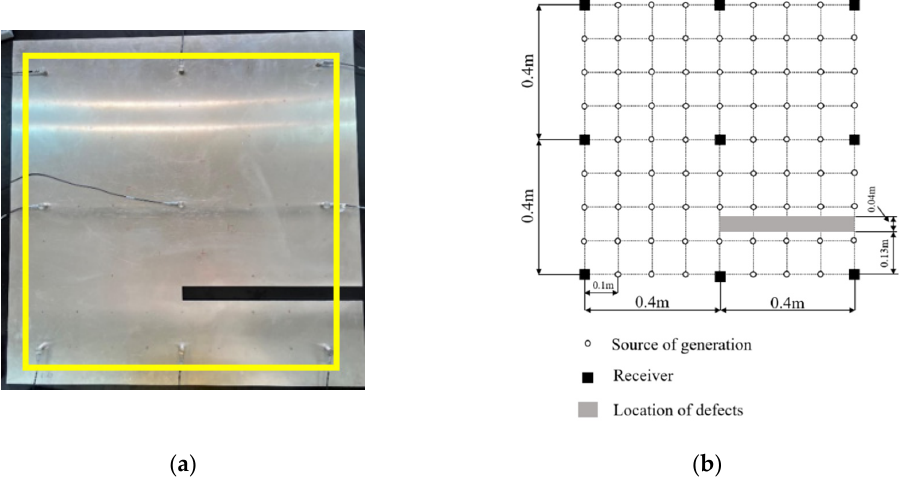
Figure 14. Overview of the specimen: ( a ) photograph of the specimen; ( b ) schematic diagram of the